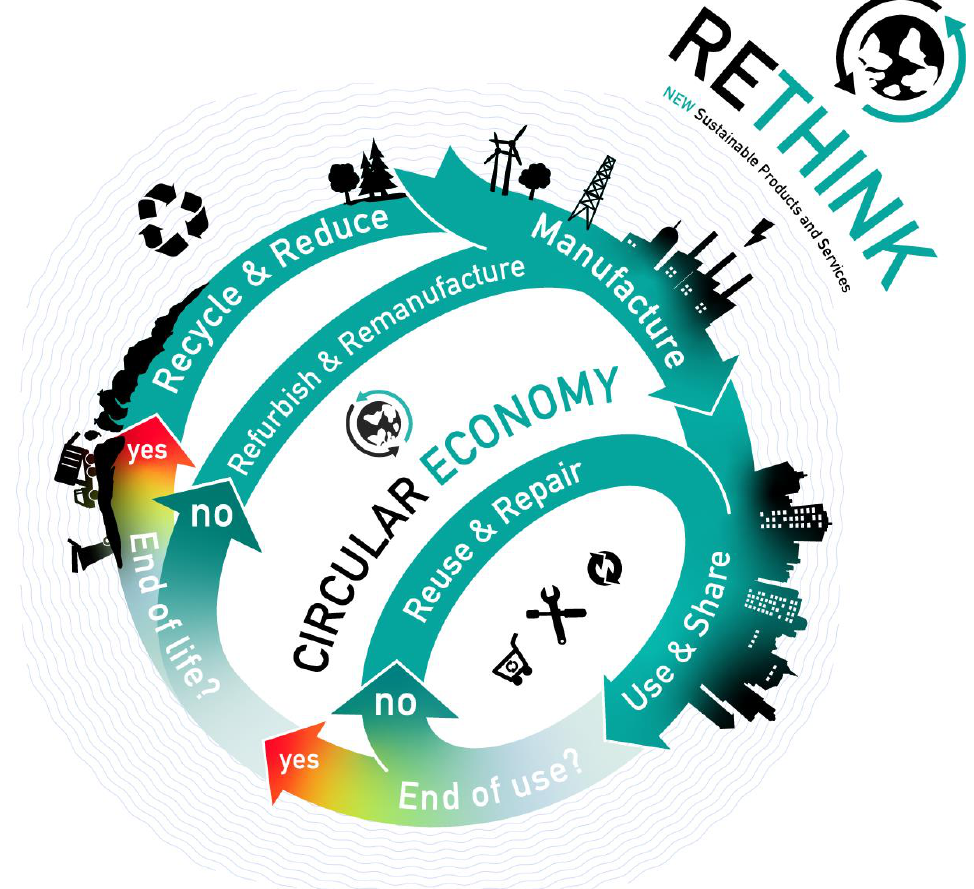
Figure 1. Circular Economy framework.